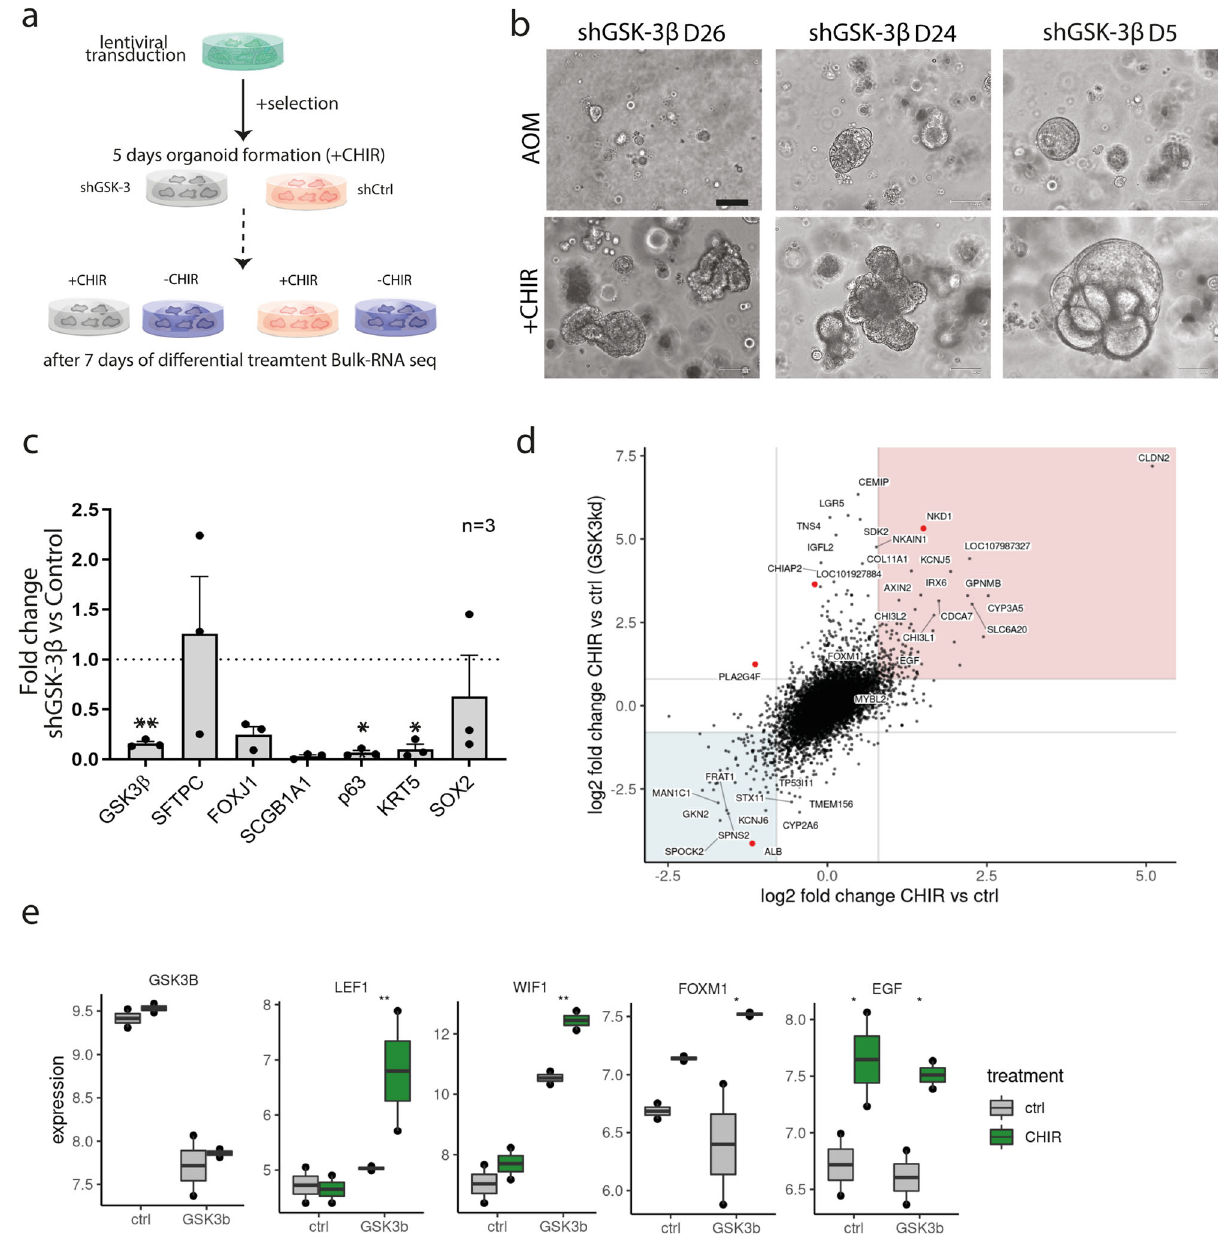
Fig. 5 CHIR 99021 is required for alveolar organoids formation and differentiation. a Experimental outline of GSK-3 β knockdown in alveolar organoids. b shGSK-3 β progenitors do not have organoid forming potential in medium without CHIR99021, as shown on representative images from three independent biological replicates. Scale bar: 100 µ m. c Relative quanti fi cation of gene expression in shGSK-3 β and control organoids reveals a strong reduction in expression of bronchial markers in presence of CHIR, while the SFTPC level remains not signi fi cantly altered. n = 3 of 3 independent pairs of donor lines (shControl and shGSK-3 β ). Data are presented as mean + / − SD. ** p = 0.006 for GSK3 β , * p = 0.011 for TP63 , * p = 0.037 for KRT5 , calculated by two-tailed Students t -test. d Scatter plot of gene expression changes due to CHIR treatment in shGSK-3 β and mock (non-mammalian shRNA) background derived from bulk RNA-seq data of two different donor organoid cultures. Genes with signi fi cant differences in the transcriptomic responses (adj. p -value < 0.05) are highlighted in red. Red and blue areas denote concordant responses with log2 fold-change> 0.8. e Normalized expression values of speci fi c genes (GSK3B, Wnt targets LEF1 and WIF1, FOXM1, EGF) in both genetic backgrounds (ctrl and GSK3b) + / − CHIR treatment (ctrl and CHIR). *** p < 0.001, ** p < 0.01, * p < 0.05 (DESeq2 Wald